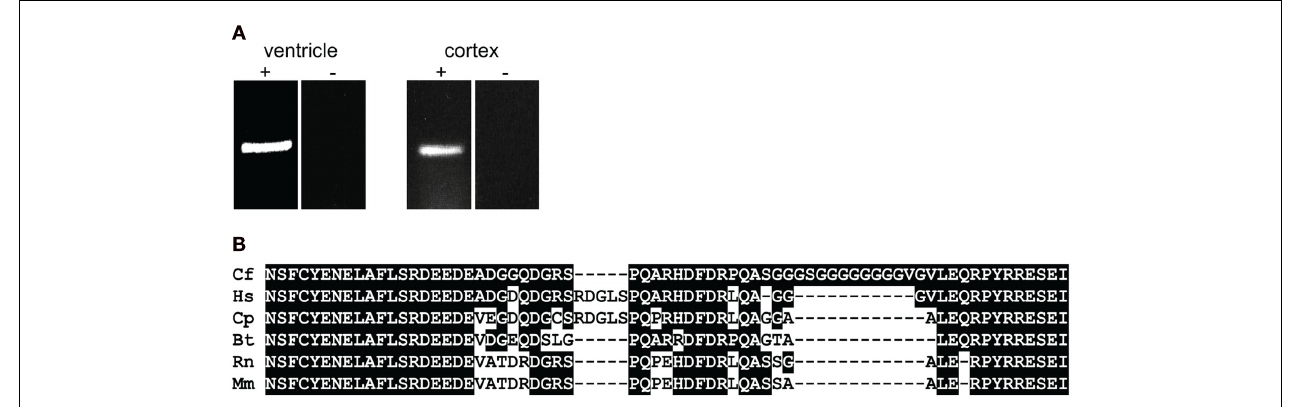
indicates minus RT control. (B) Homology comparison of dog (Cf), human (Hs), guinea pig (Cp), bovine (Bt), rat (Rn), and mouse (Mm) K IR 2.2 carboxy-termini. Conserved residues are depicted in white font on black background.